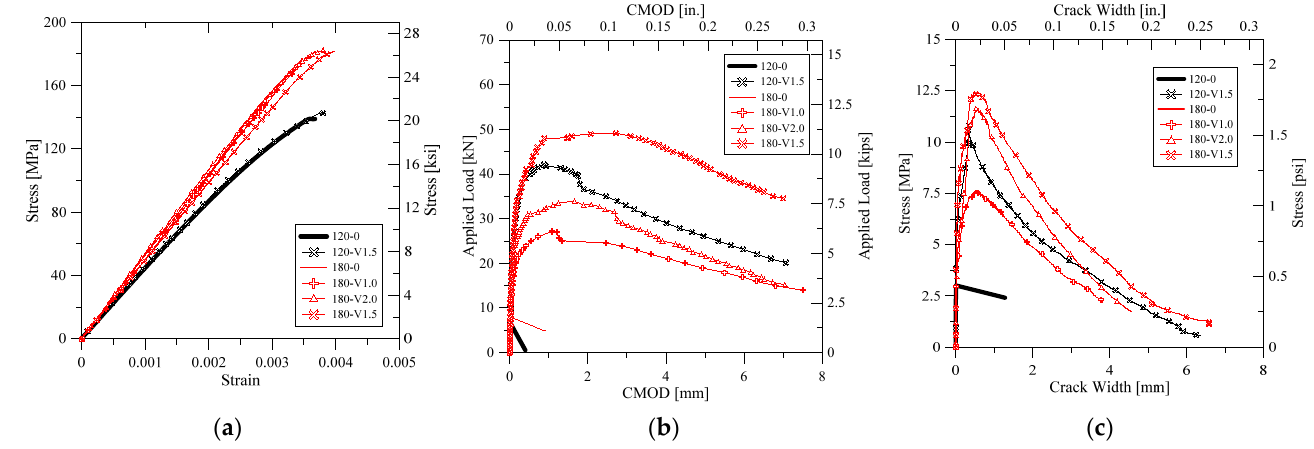
Figure 3. Material test setup and typical failure of material test specimens: ( a ) Compressive strength